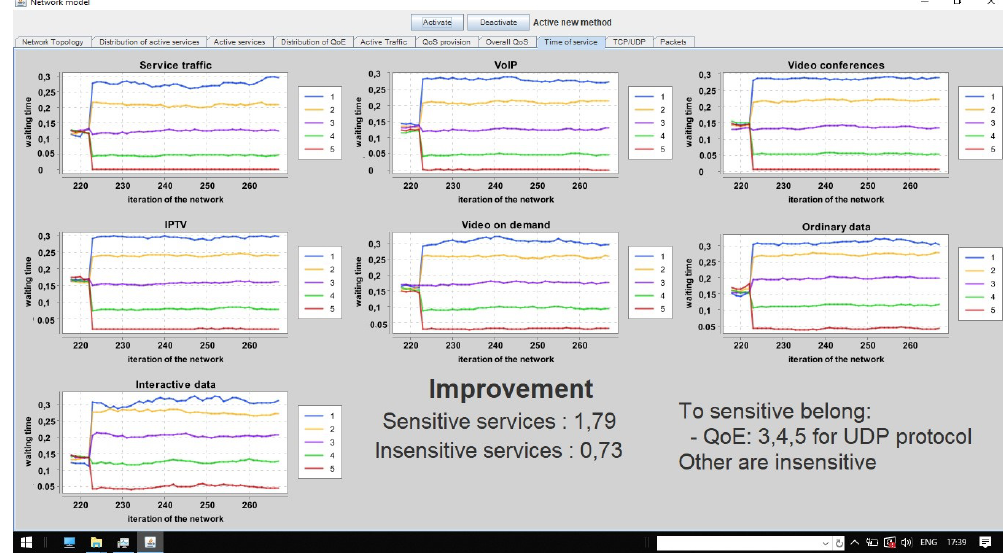
Figure 30. The average waiting time for each session with corresponding QoE score using the proposed method.